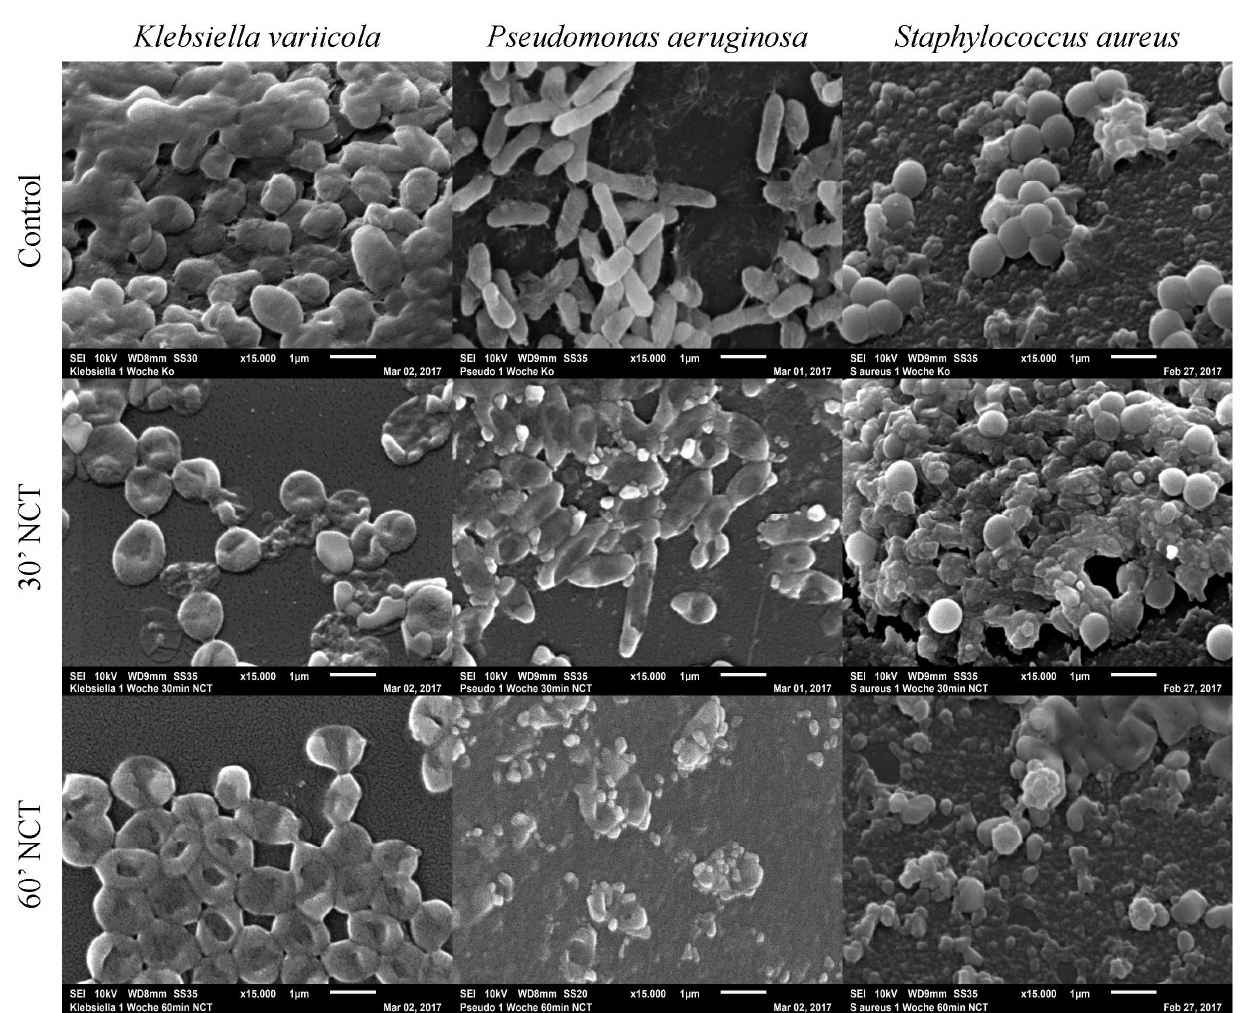
Figure 8. Scanning electron microscopy of 1-week-old Klebsiella variicola, Pseudomonas aeruginosa, and Staphylococcus au-reus biofilms. Upper row: mock-treated control biofilms (Magnification 15,000×); middle row: biofilms treated with NCT, for 30 min (Magnification 15,000×); lower row: biofilms treated with NCT, for 60 min (Magnification 15,000×). Specimens were analyzed by scanning electron microscopy (SEM, JSM-6010LV, JEOL GmbH, Freising, Germany).